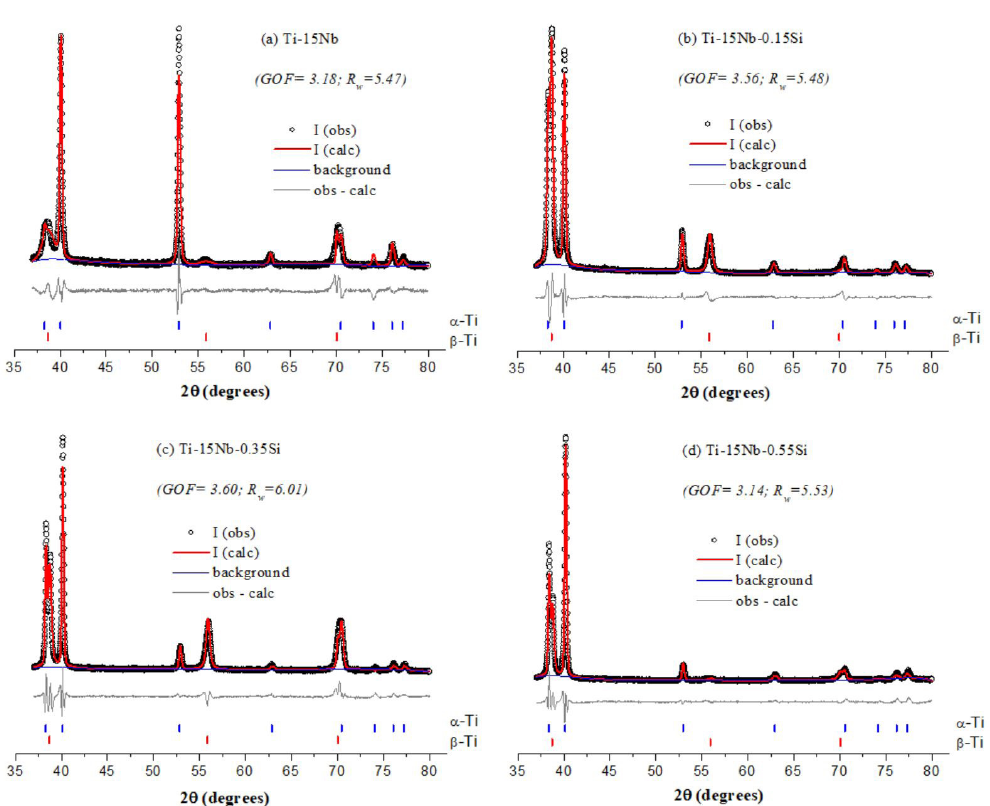
Figure 2. Observed (open circles) and calculated (solid red line) XRD patterns of FC Ti-15Nb-xSi samples. The difference (solid grey line) is shown at the bottom of the image and Bragg reflections are indicated by vertical marks.